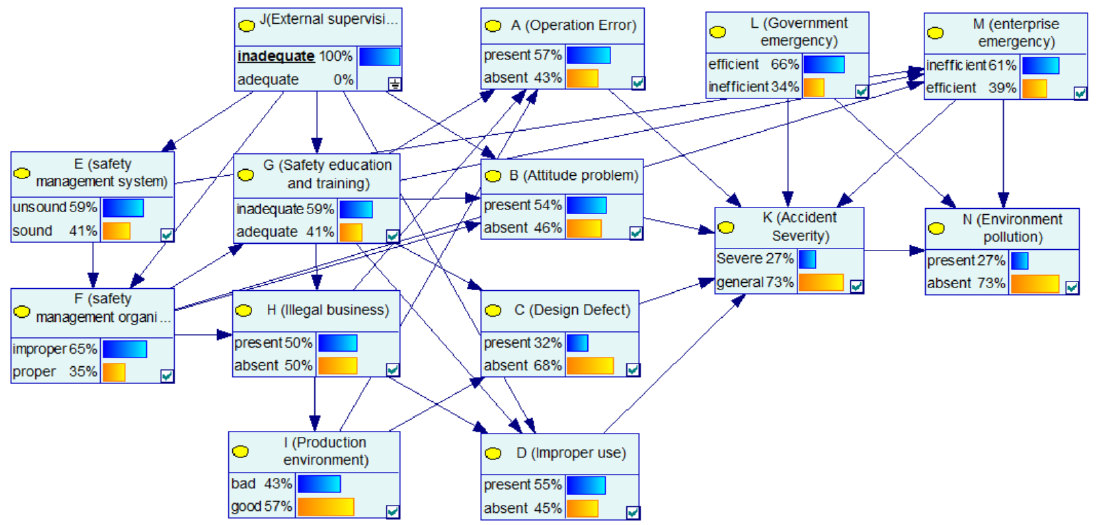
Figure 5. The posterior probability of other nodes when the state of the J node is inadequate.